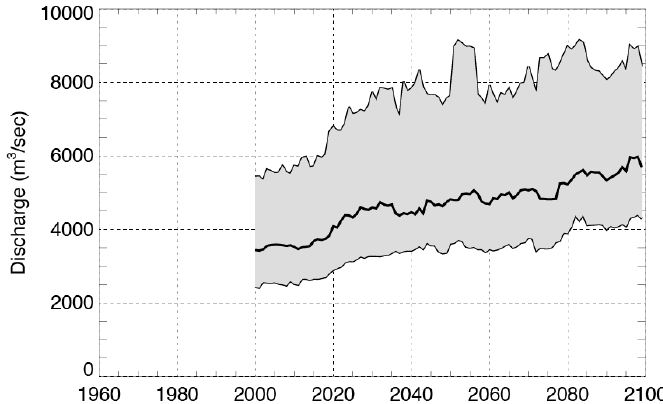
Figure 8. The black solid line is the median of the 19 values of 100-yr flood estimates using the data from a fixed moving time window of 40 years in the past. The shaded area represents the 95% confidence intervals of the estimates.